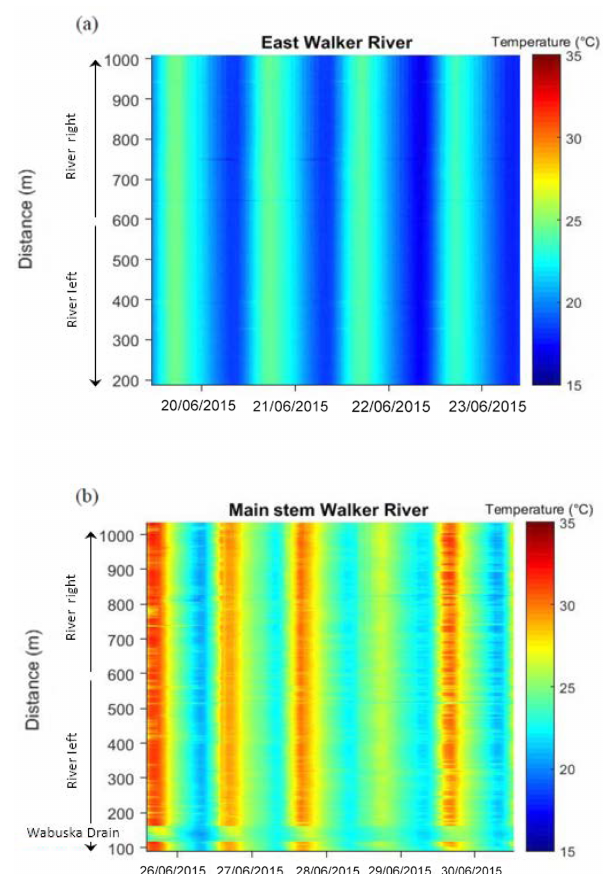
Figure 2. Stream temperatures measured for the length of the DTS cable at East Walker River (a) and main stem Walker River (b) DTS sites. Wabuska Drain, which was not flowing but had standing water during sampling, is located at cable distance 110–175m in the main stem Walker River